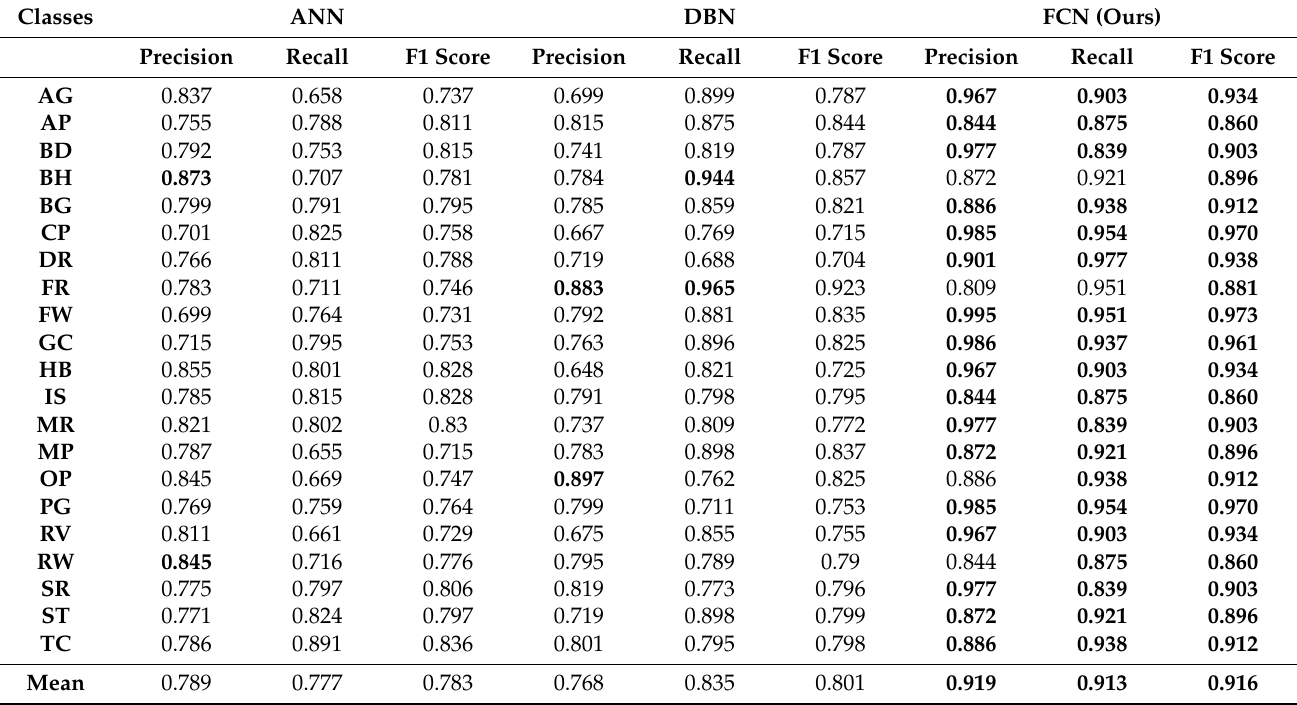
Table 4. Scene classification results against three classifiers on UCM